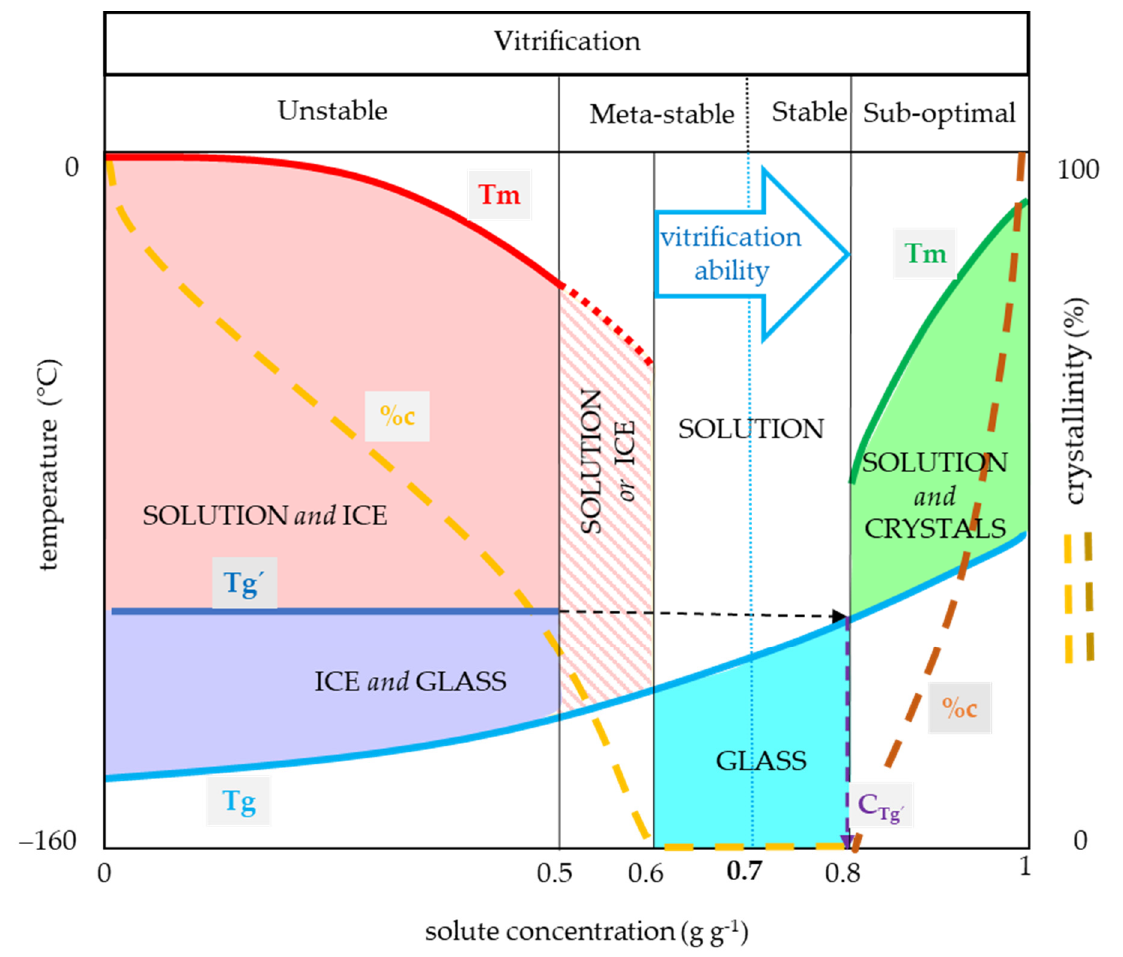
Figure 7. General CPA thermal diagram demonstrating the effect of solute concentration on vitrification ability (VA). Four areas of solute concentration differ in their vitrification ability: (1) low concentration (0–0.5 g g − 1 ) results in crystallization of water during cooling with the exception of an extreme CCR, (2) medium concentration (0.5–0.6 g g − 1 ) carries the risk of crystallization of water during warming, (3) optimal concentration (0.6–0.8 g g − 1 ) for the glass transition, (4) high concentration (0.8–1.0 g g − 1 ) carries the risk of solute crystallization, osmotic damage or CPA toxicity. x -axis—solute concentration (g g − 1 ), left y -axis—temperature (°C), right y -axis—percentage of crystallinity of water or solute (% w/w ), Tg—glass transition temperature of the solution, Tg´—glass transition temperature of the freeze-dehydrated solution, Tm—melting point of water (red line) or solute (green line), %c—percentage of crystallinity of water (orange) or solute (brown), C g —concentration of the freeze-concentrated solution. The solute concentration of 0.7 g g − 1 represents the proposed universal vitrification concentration of CPAs.